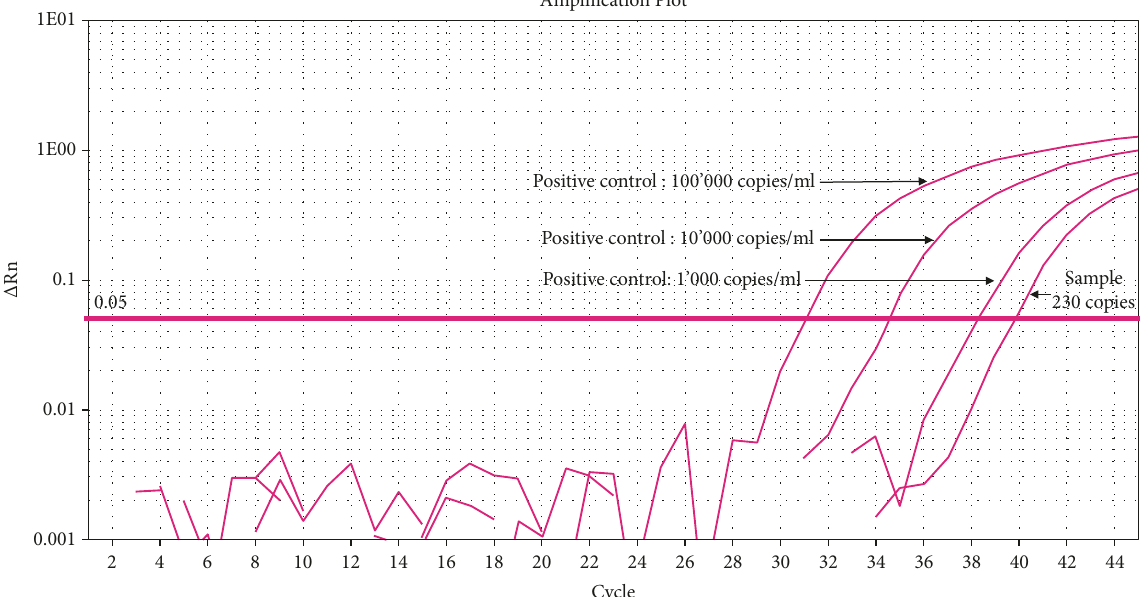
Figure 4: Amplification plot from the ileal sample concerned during the real-time PCR showing the amplification curve of specific T. whipplei DNA to 230